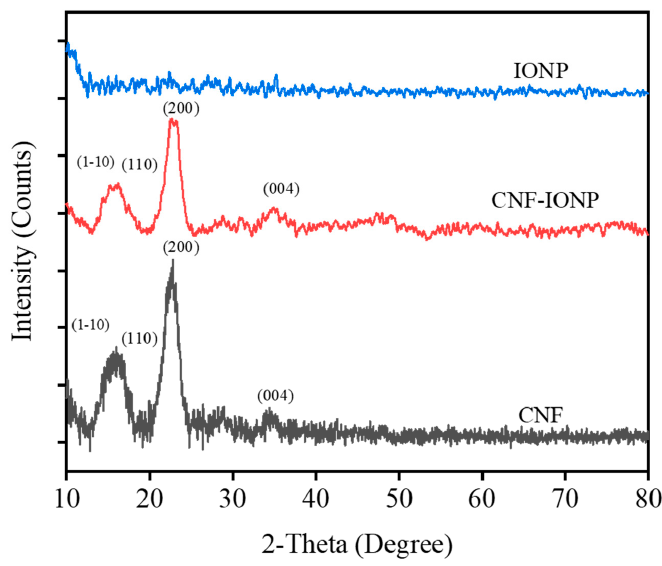
Figure 5. XRD spectra of the freeze–dried IONP, CNF–IONP, and CNF aerogels. Additional SEM analysis was conducted to evaluate the internal structure and mor- phology of IONP, CNF, and CNF-IONP aerogels (Figure 6). Figure 6A shows a